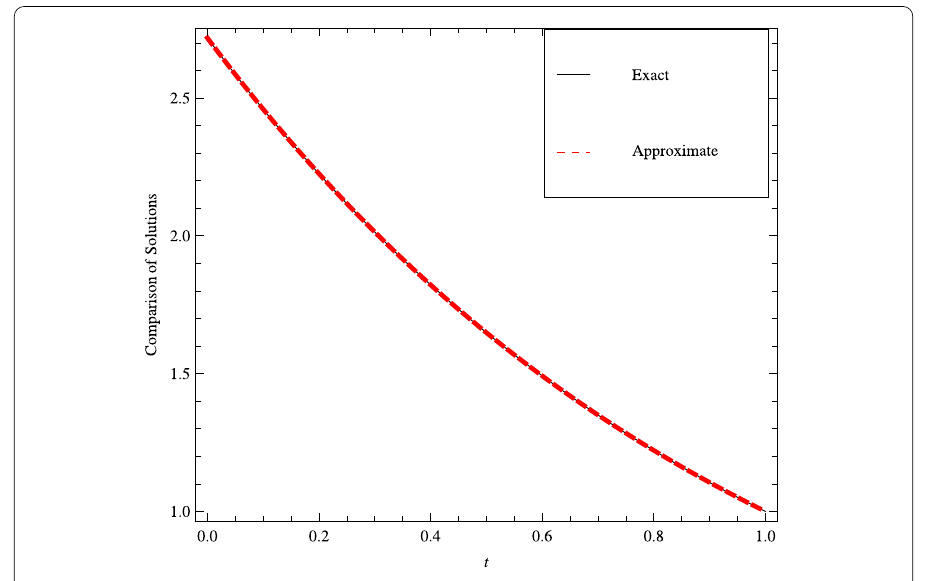
Figure 2 Comparison of the 4th term MHATM solution and the exact solution of the TFNWS equation when x = 1